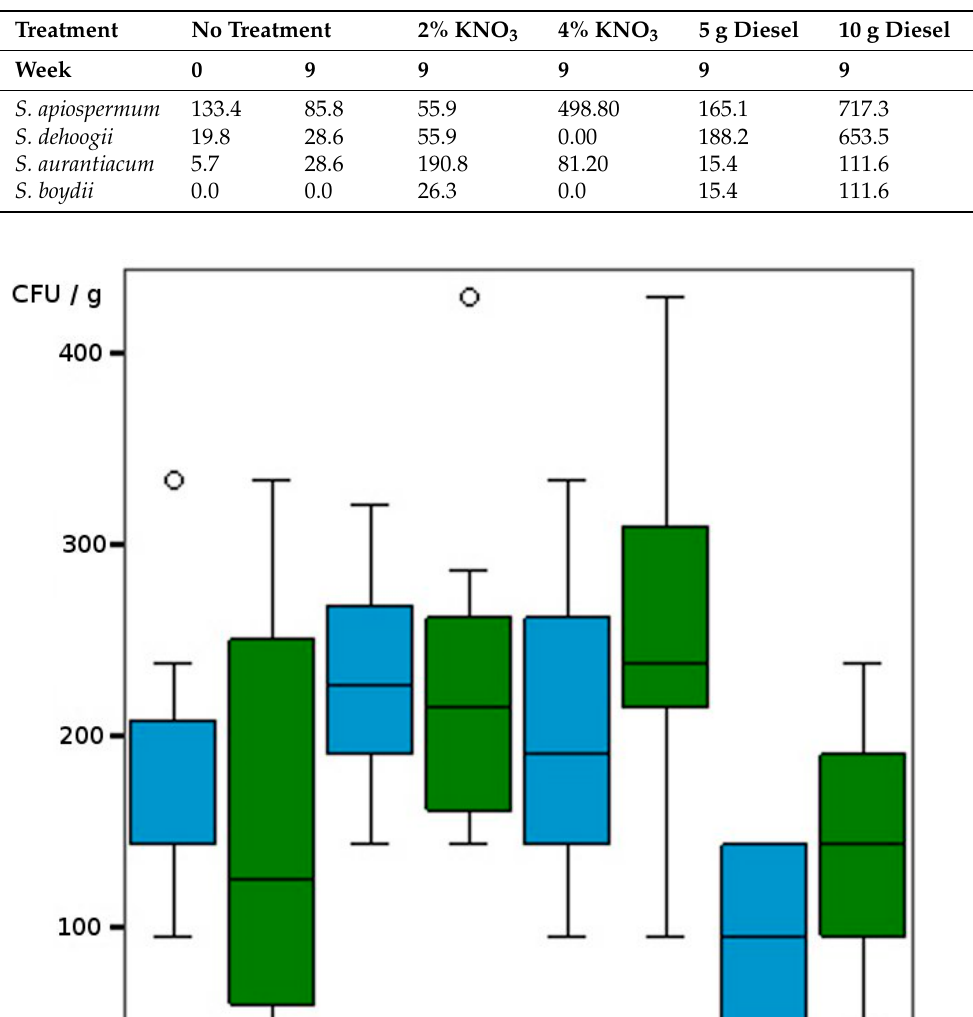
Table 3. CFU values of Scedosporium species per gram soil (dw) after 0 and 9 weeks of incubation in (un)treated pots at 25 ◦ C. A pooled sampling was used for the determination of CFU of week 0.